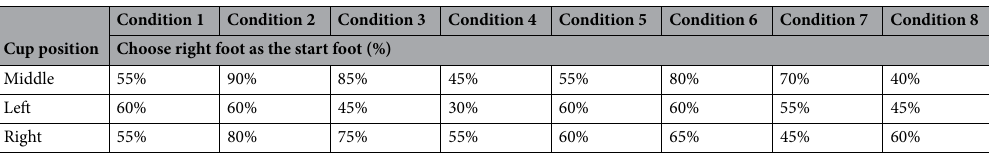
Target position effect. Figure 9 shows the results of the path selection judgement test. The dashed line represents when there was a 50% probability of choosing to walk to the right side of the obstacle/walkway. Probabilities higher than 50% mean that the participant preferred to choose walking on the right side of the obstacle to reach the target. However, it can be seen that participants chose to walk on the left side of the obstacle/walkway when walking to the target when the target was shifted as close as 15 cm to the left side relative to the middle of the shelf.